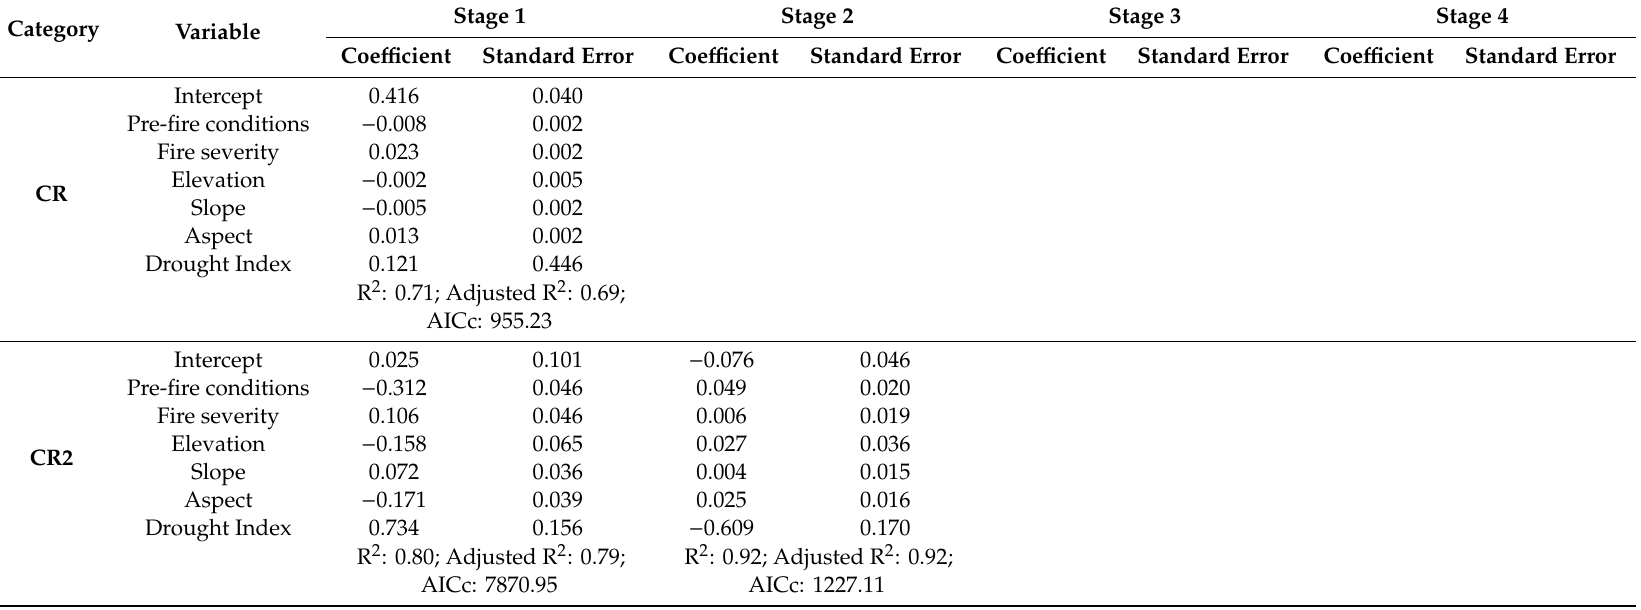
Table 5. Modeling results for Tasseled Cap Wetness (TCW) recovery categories at each